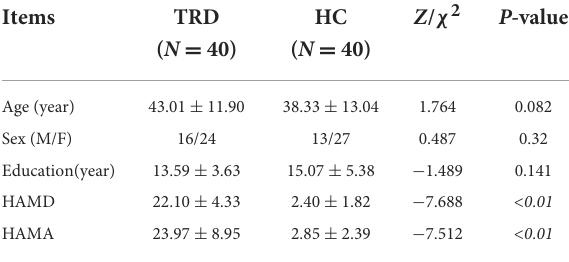
TABLE 1 Demographic and clinical characteristics of the study participants.